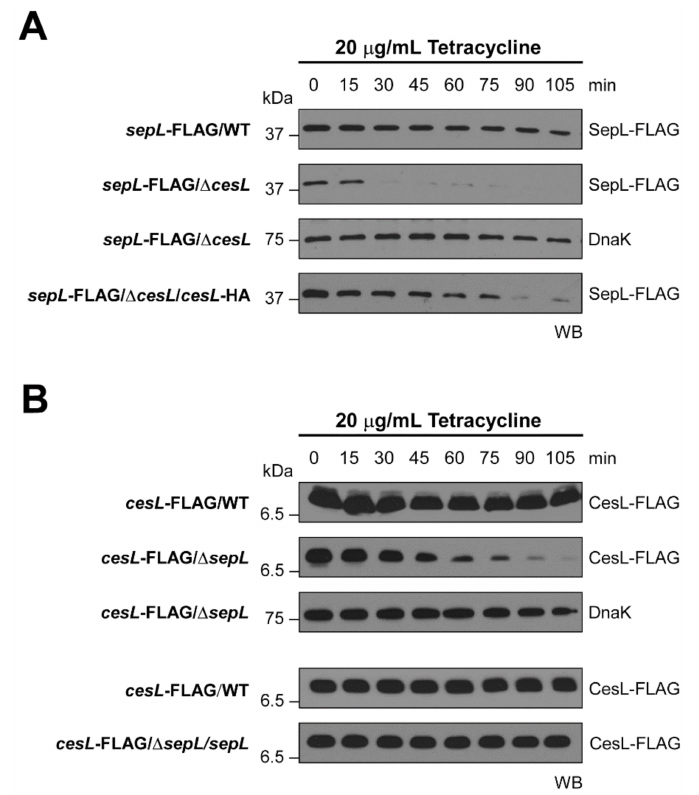
Figure 4. Interdependent stability of SepL and CesL proteins. ( A ) Immunoblotting showing the protein levels of chromosomally encoded SepL-FLAG expressed in wild-type EPEC (WT), ∆ cesL mutant, and the ∆ cesL strain carrying plasmid pMATcL2HA producing CesL-HA. ( B ) Immunoblotting showing the protein levels of chromosomally encoded CesL-FLAG in wild-type EPEC (WT), ∆ sepL mutant, and the ∆ sepL strain carrying plasmid pMATpL expressing untagged SepL. After halting de novo protein synthesis by addition of tetracycline, whole cell samples were collected every 15 min during 105 min. DnaK was used as a protein loading control. Samples were normalized according to the culture OD 600 at the time of